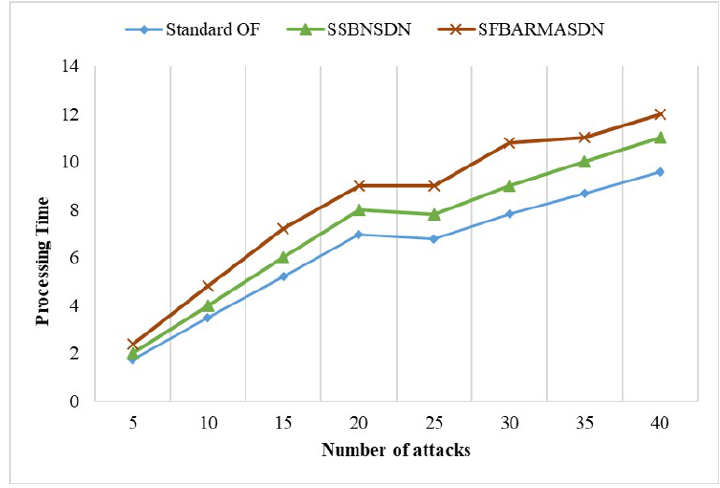
Figure 9. Comparison of the processing time among the standard OpenFlow, SSBN SDN , and SFBARMA SDN